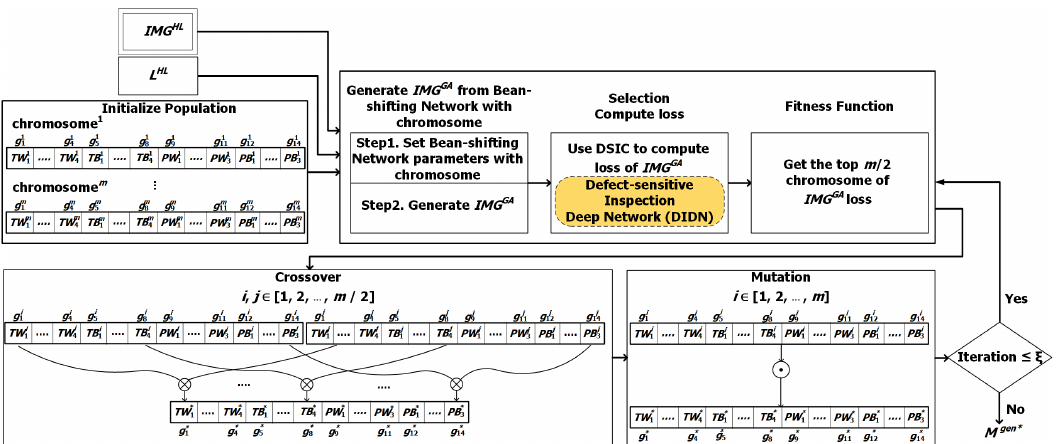
Figure 8. The structure and workflow of the genetic algorithm (GA)-based optimizer. This figure describes the corresponding module design in the top-left corner of Figure 7.